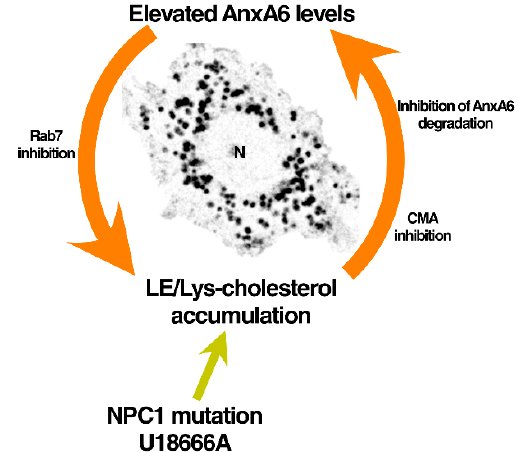
Figure 6. Scheme depicting the feedback loop of AnxA6 and LE-Chol levels in NPC1 mutant cells. NPC1 loss-of-function mutations or pharmacological NPC1 inhibition (U18666A) lead to late endosome/lysosome (LE/Lys)-cholesterol accumulation [1,6,61]. This interferes with Lamp2A-dependent chaperone-mediated autophagy (CMA) [31,48], which leads to reduced AnxA6 protein degradation (this study). Elevated AnxA6 protein levels promote Rab7 inactivation, which further contributes to cholesterol accumulation in LE/Lys (this study and [25]). In fact, diminution of active Rab7 in NPC1 mutant cells could also inhibit CMA [62]. This inhibitory feedback loop can be overcome by Lamp2A overexpression, which activates CMA [49], leading to reduced AnxA6 levels and concomitantly, also induces the diminution of LE/Lys-cholesterol accumulation (this study). Lamp2A-induced restoration of LE-cholesterol export being responsible for reduced AnxA6 protein levels cannot be completely ruled out. Alternatively, AnxA6 depletion in NPC1 mutant cells increased Rab7 activity [25], which restored cholesterol export from LE/Lys. Taken together, this feedback loop connects cholesterol levels in LE/Lys with CMA-mediated AnxA6 protein degradation, with CMA functionality being highly dependent on cholesterol levels in the LE/Lys compartment. N, nucleus.